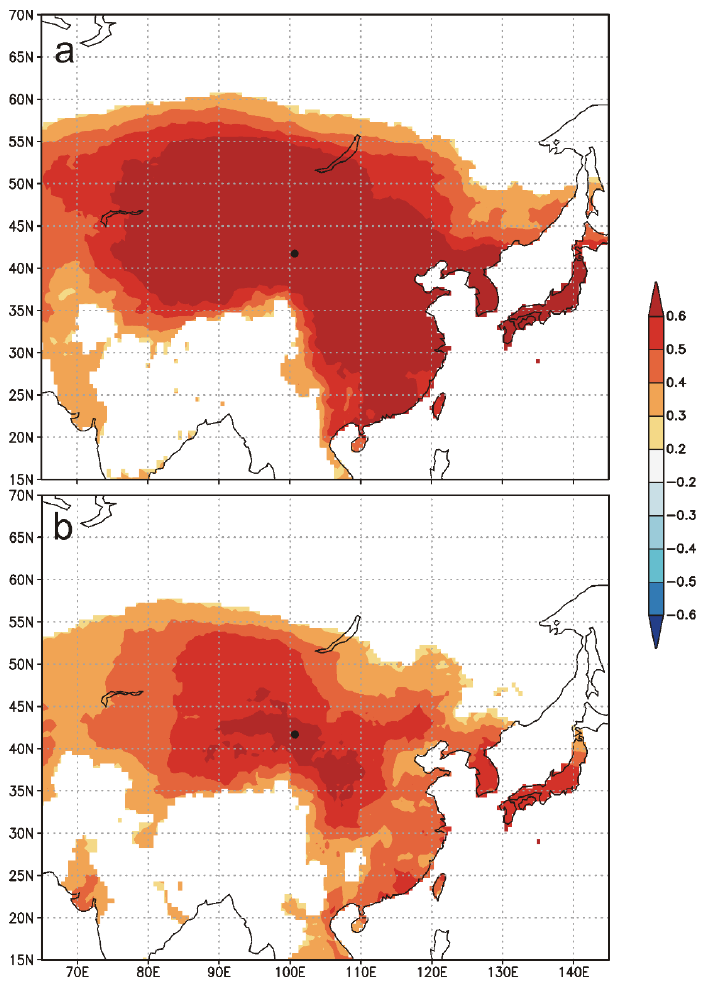
Figure 6. Patterns of field correlation ( p < 0.1). ( a ) Observed T DS with December–September CRU TS4.05 mean maximum temperature (the grid system is 0.5° × 0.5°); ( b ) Reconstructed T DS with December–September CRU TS4.05 temperature. Black dot represents sampling site.